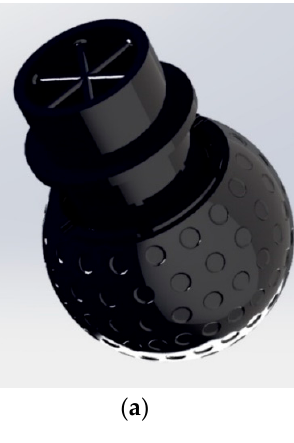
Figure 9. Fabrication of the rotor bowl: ( a ) the ABS inner structure of the rotor around which epoxy is cast; ( b ) the two-part mold assembly surrounding the inner